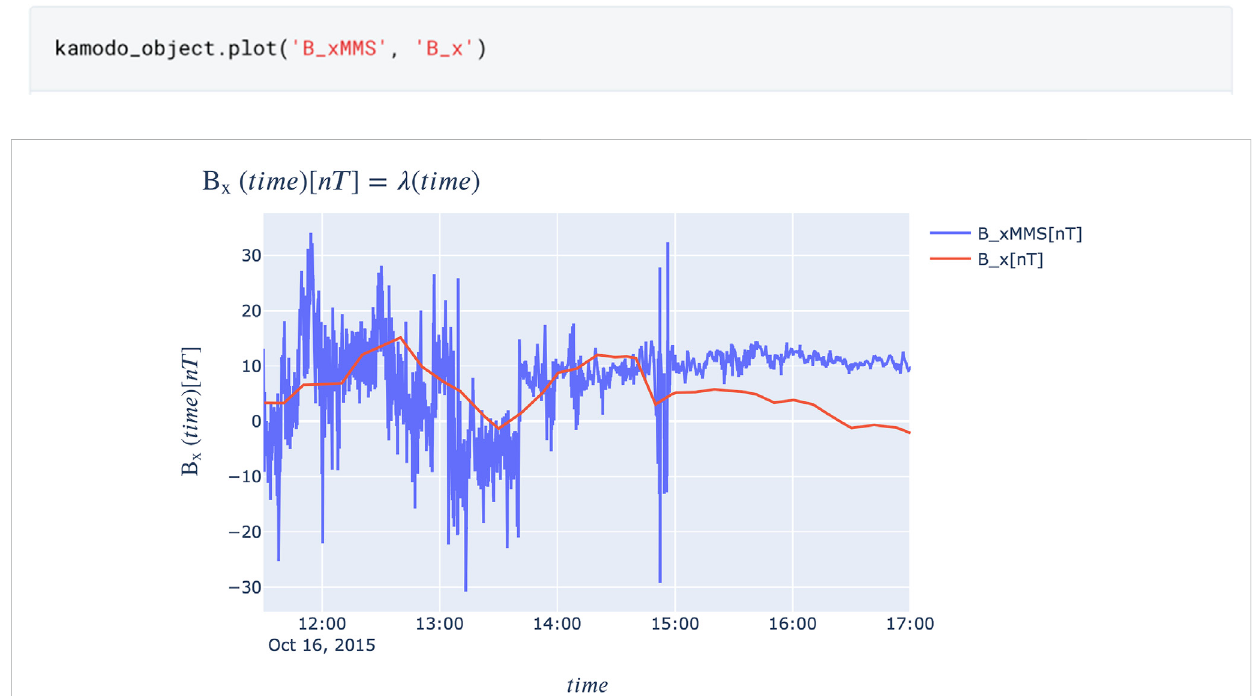
FIGURE 7 Time series plot of the observed B_x magnetic fi eld component (blue) with the modeled one (red).